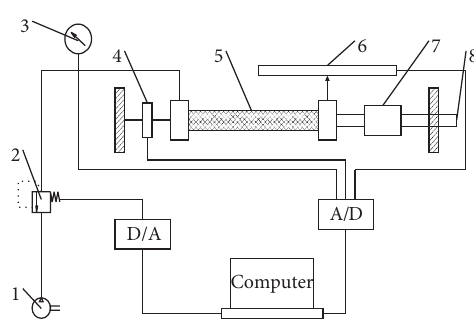
Figure 3: The whole structure of the artificial leg.